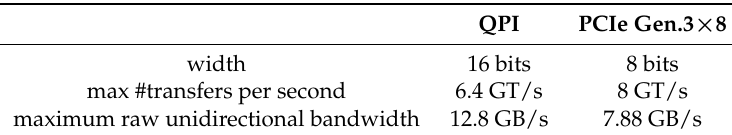
Table 1. QPI and PCIe